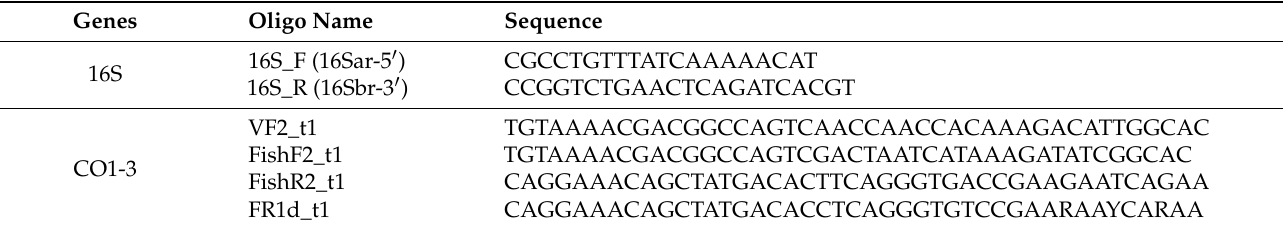
Table 4. Primer set used in this